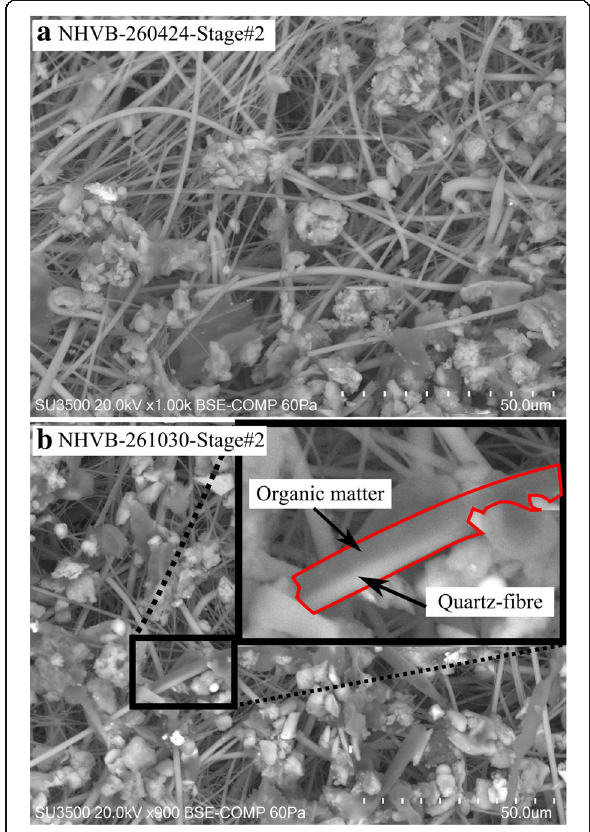
Fig. 6 SEM images of filters for stage #2 sampling at the GC site in a spring and b autumn. The adhesive organic matter that sticks to the quartz fiber is surrounded by the red line. From the morphology, we suspect that the material was dense liquid when it was suspended in air. This matter probably affects the collection efficiency of the coarse particles on the